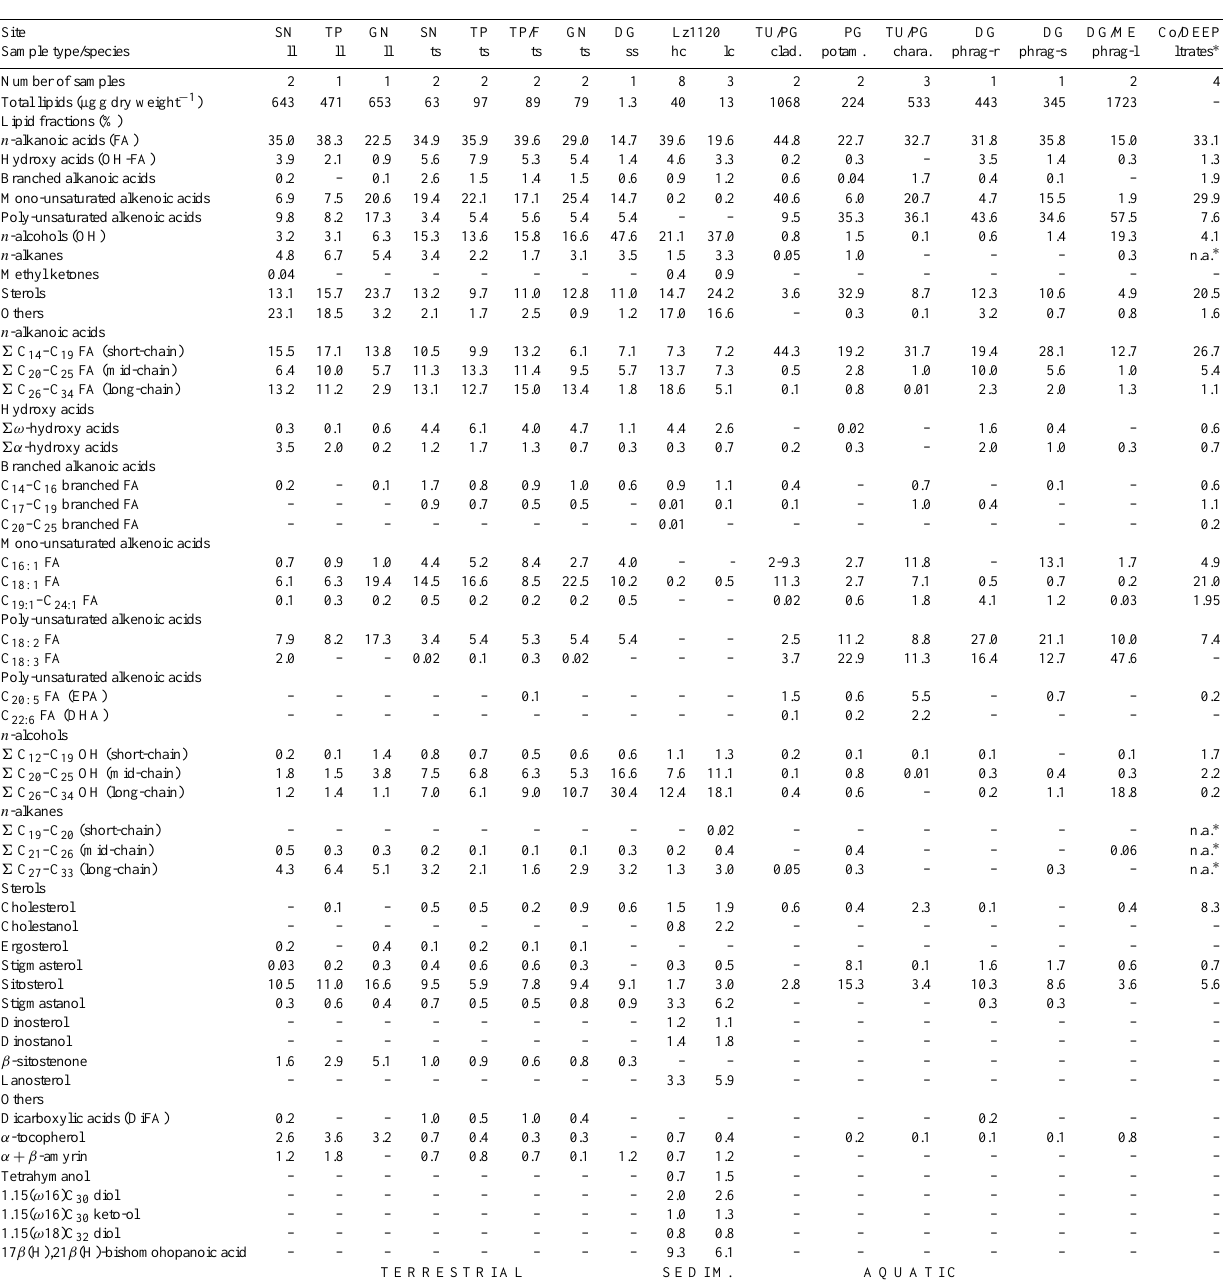
Table 2. Composition of the total lipid extracts (TLEs) and amounts of compound classes, sub-categories and individual lipids of soils, sediments, leaf litter, macrophytes and water filtrates from the Lake Ohrid Basin. Values are given as percentages of the total lipids (% lipids ) ; SN is St Naum, TP is Trpejca, GN is Galicica National Park, DG is Dogana; ME is Memëlisht; ll is leaf litter, ts is topsoil, ss is subsoil, hc is high-carbonate sediment, lc is low-carbonate sediment, clad. is Cladophora , potam. is Potamogeton , chara. is Characeae spp., phrag-r, -s, -l is Phragmites spp. roots, stem, leaves. ∗ Indicates only polar fractions were analysed. For the full list of compounds see Supplement.